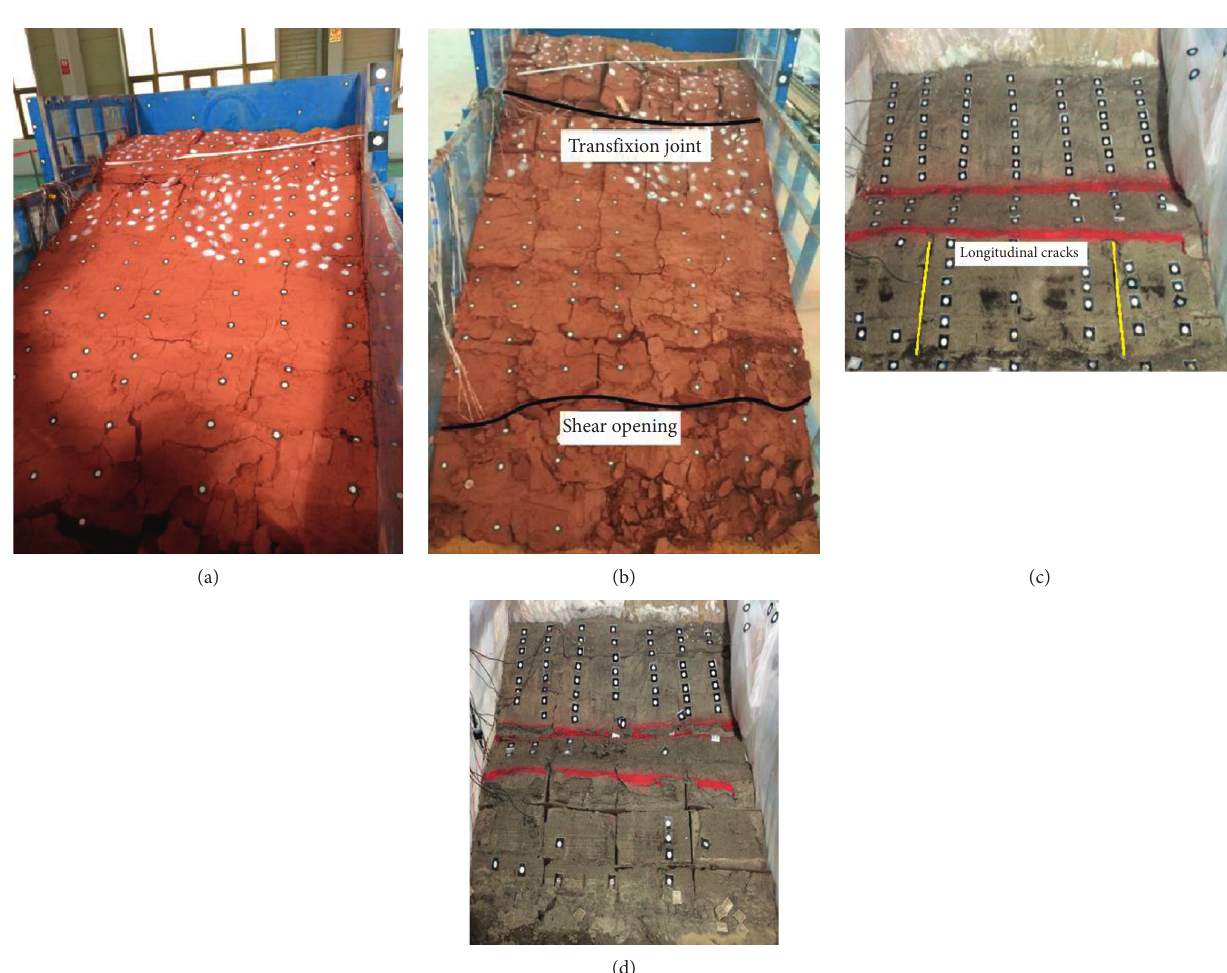
Figure 16: The damage phenomenon of the slope: (a) the damage phenomenon of Huaping slope under vertical seismic load; (b) the damage phenomenon of Huaping slope under horizontal seismic load; (c) the damage phenomenon of Lijiang slope under vertical seismic load; (d) the damage phenomenon of Lijiang slope under horizontal seismic